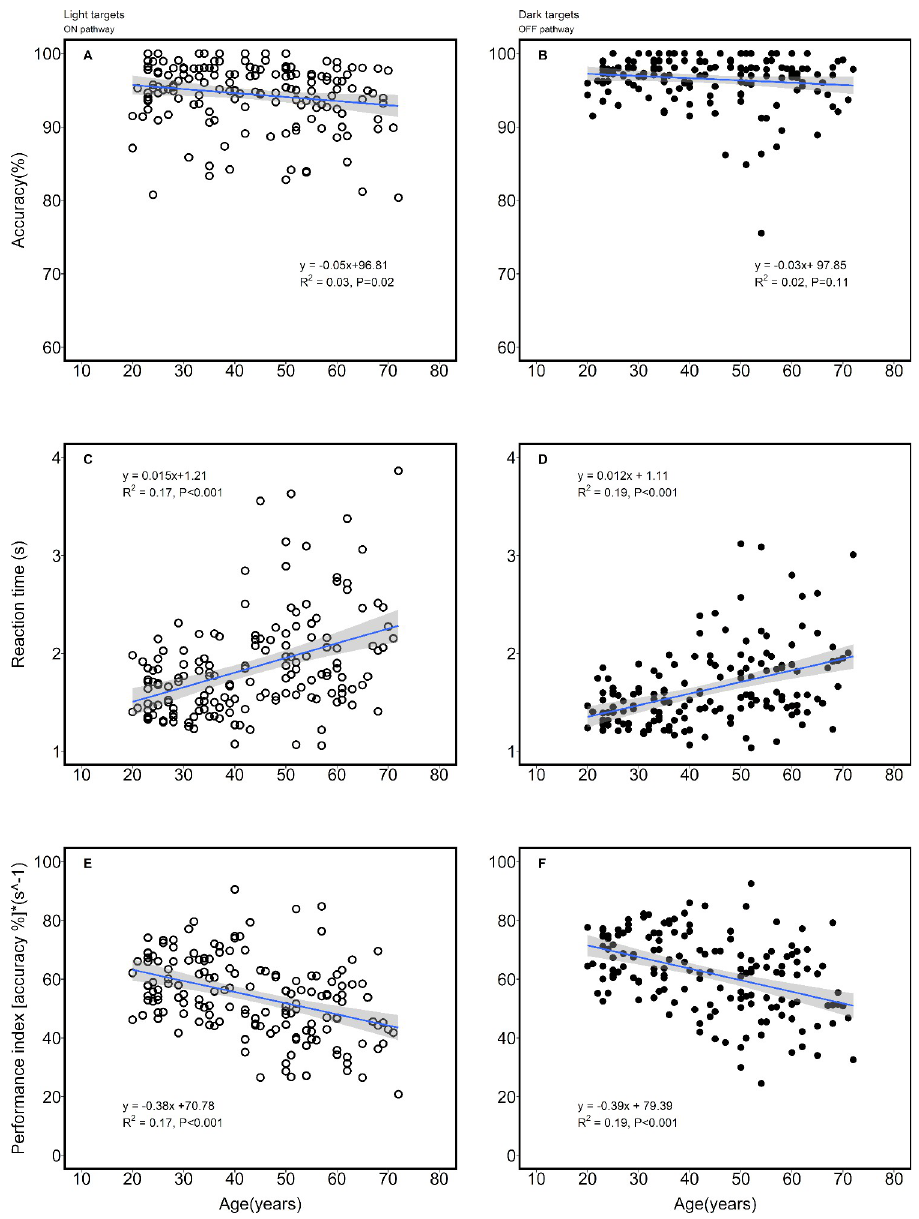
Fig 4. Left panels show outcome variables (accuracy, reaction time and performance index) for light targets as a function of age. A similar representation shows the data for the right panels. The blue solid line in each of the panels represents the slope of the linear regression and the grey region represents the standard error of the